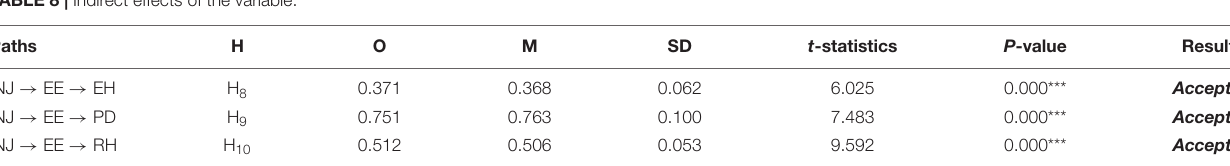
TABLE 8 | Indirect effects of the variable. Paths H O